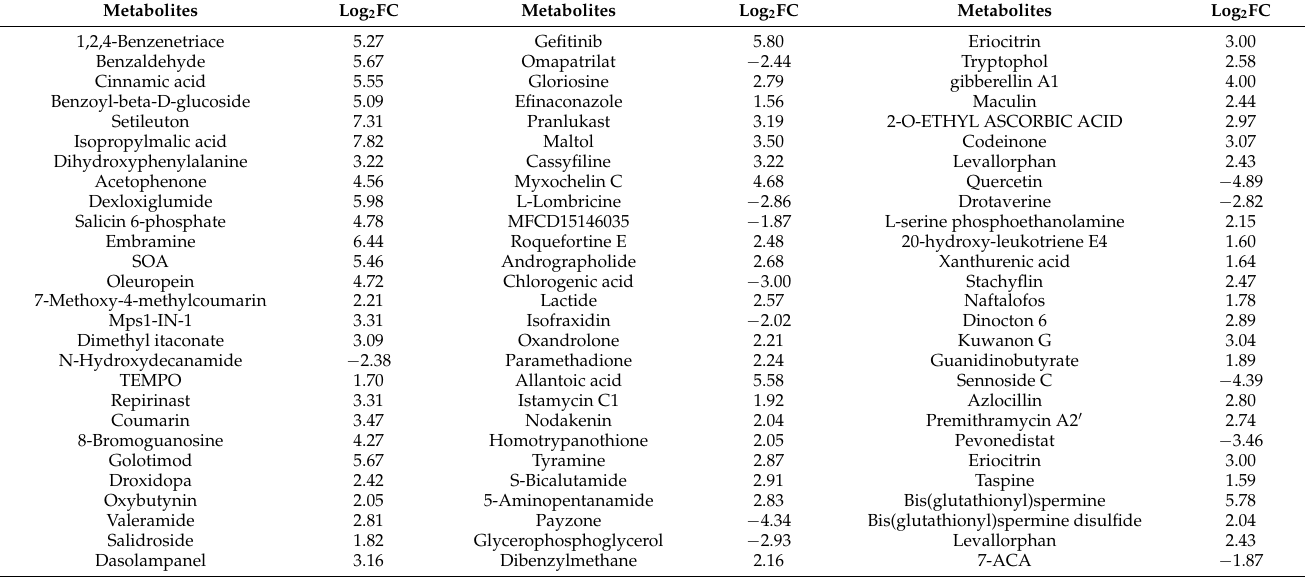
Table 2. Differentially expressed metabolites identified in roots using non-targeted metabolomes.